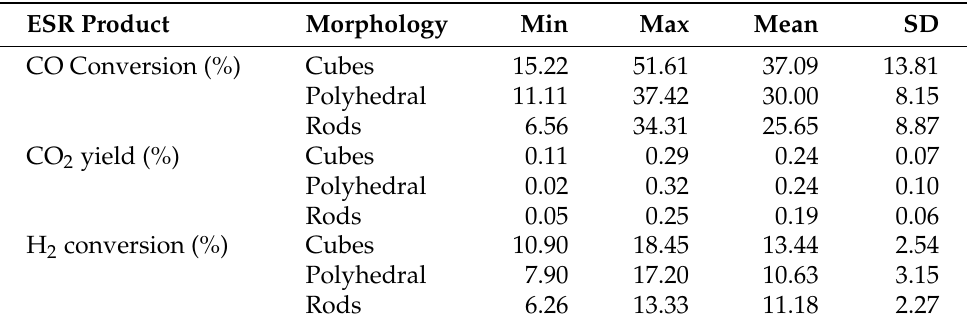
Table 2. The summary statistics include the average, minimum, maximum, and standard deviation (SD) of ESR products with various